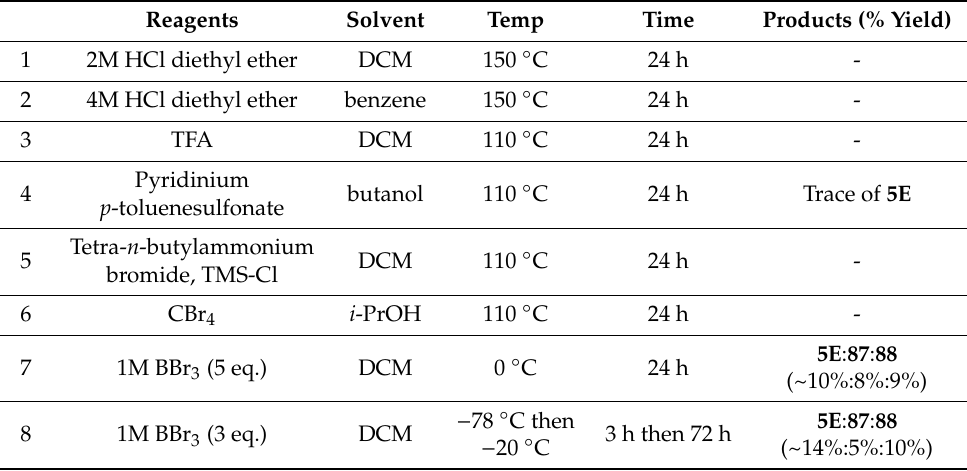
Table 3. Summary of conditions explored for removal of EM protecting group from 86 .